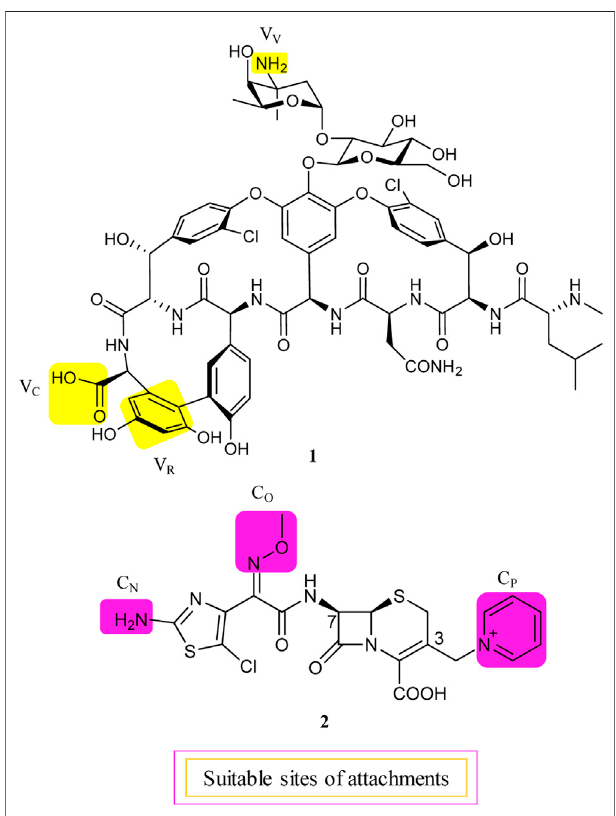
FIGURE 1 | Suitable attachment positions in vancomycin ( 1 ) and THRX- 169797 ( 2 ).